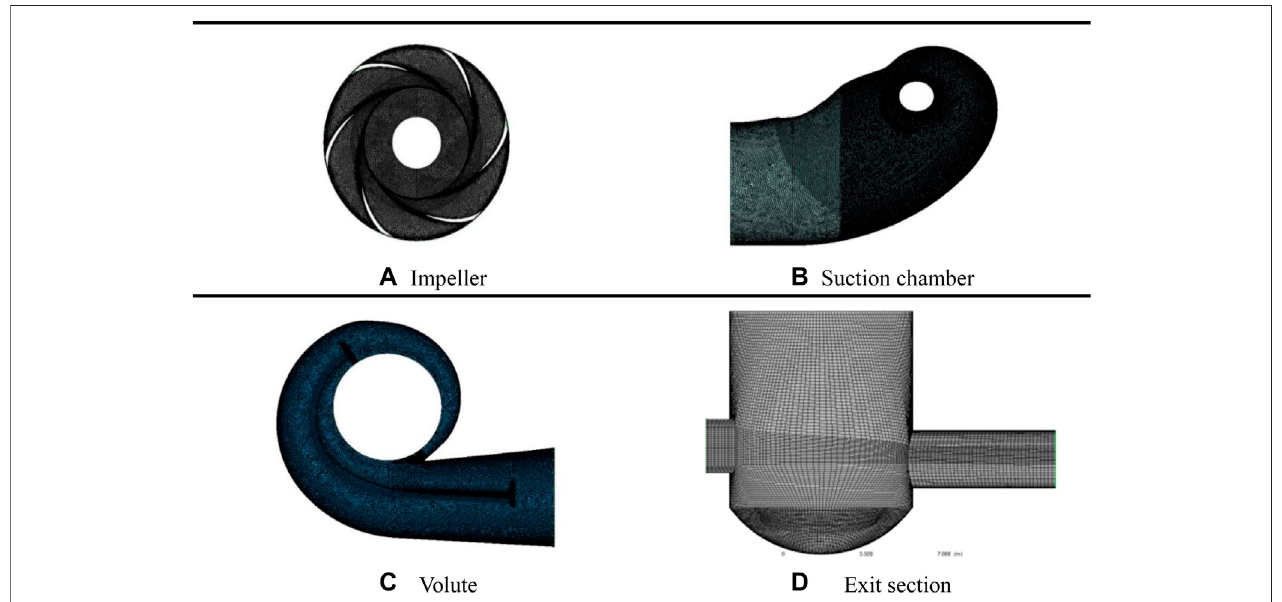
FIGURE 1 | The grid of fl ow system components. (A) Impeller; (B) Suction chamber; (C) Volute; (D) Exit section.